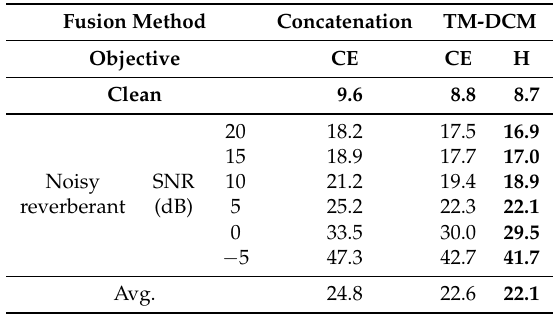
Table 4. WERs (%) for our model and decoding on simple concatenation of audio and video encoder outputs on the test sets of LRS2-BBC and LRS3-TED datasets. The boldface WERs denote the best performance in each condition. Abbreviation to understand the table: CE, cross-entropy loss only; H, hybrid CTC/attention loss.